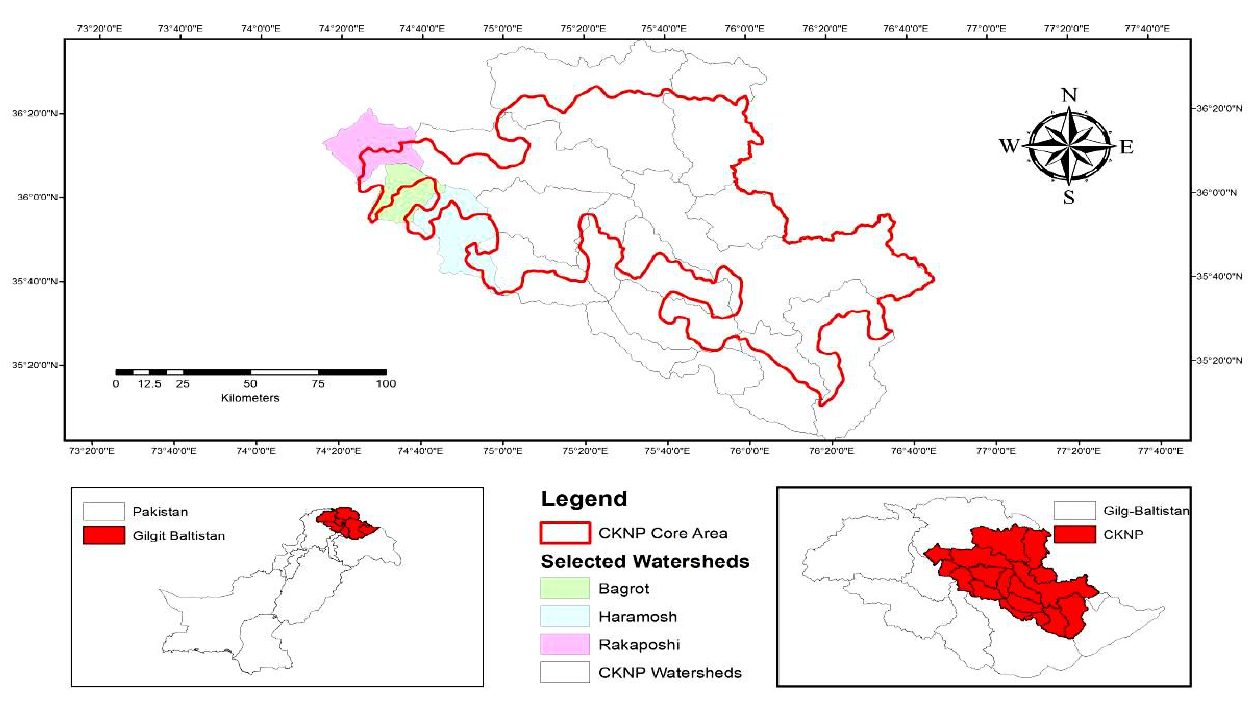
Figure 1: Central Karakoram National Park (Study